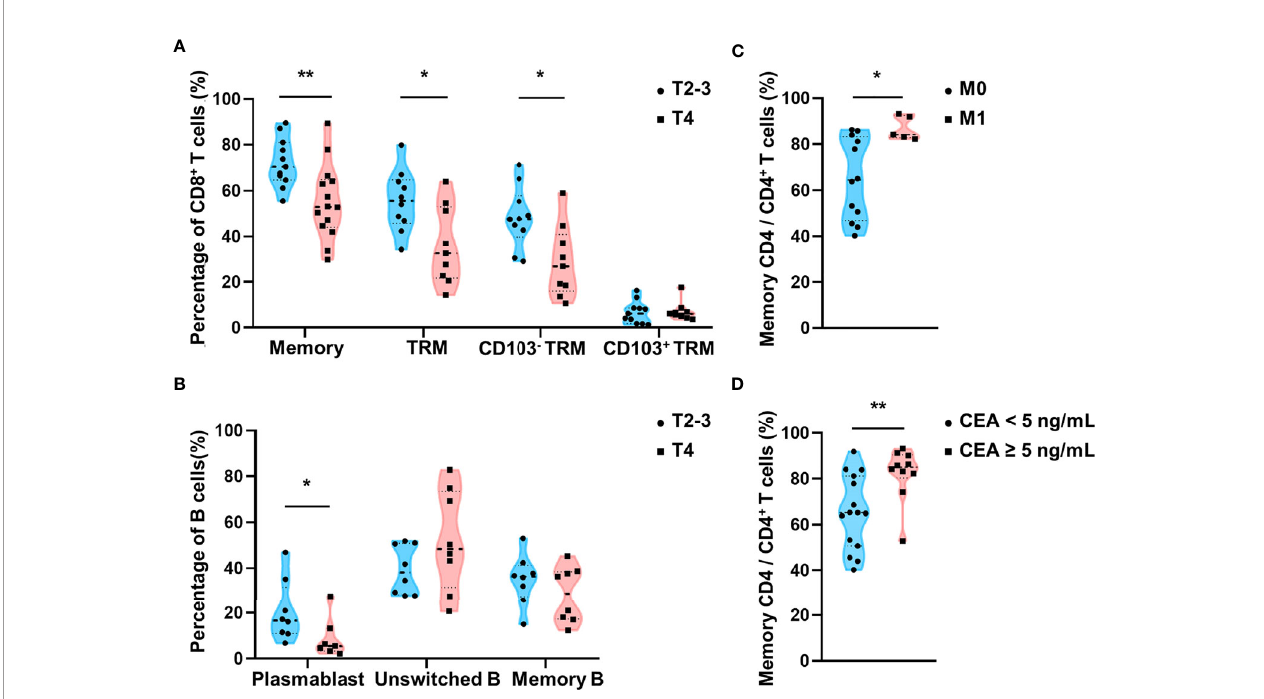
FIGURE 5 | Relationship between lymphocytes in the MES T and TNM stages and preoperative serum CEA levels. (A) Comparison of the percentages of memory CD8 + T cells, CD8 + TRM cells, CD8 + CD103 - TRM cells, and CD8 + CD103 + TRM cells in the MES T between patients with T2-3 stage CRC and T4 stage CRC. (B) Comparison of the percentages of plasmablasts, unswitched B cells, and memory B cells in the MES T between patients with T2-3 stage CRC and T4 stage CRC. (C) Comparison of the percentage of memory CD4 + T cells in the MES T between patients with M0 stage CRC and M1 stage CRC. (D) Comparison of the percentage of memory CD4 + T cells in the MES T between patients with CRC showing different preoperative serum CEA levels (<5ng/mL and ≥ 5ng/mL). (mean ± SD; *p < 0.05; **p <